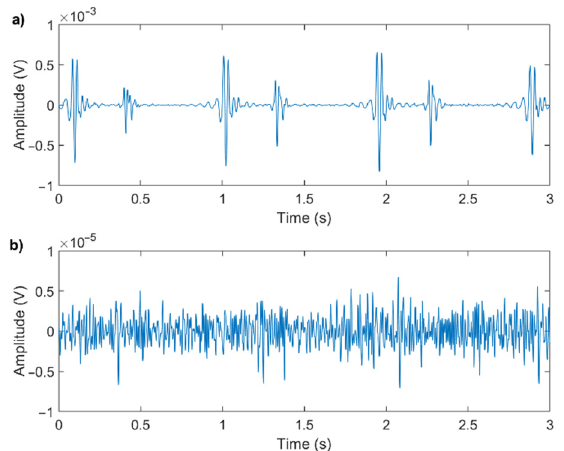
Figure 1. Comparison between ( a ) a good-quality signal (SNR = 31 dB) and ( b ) a poor-quality signal (SNR = 4 dB). The extraction of valve timing and even the SNR computation is evidently questionable in case ( b ).